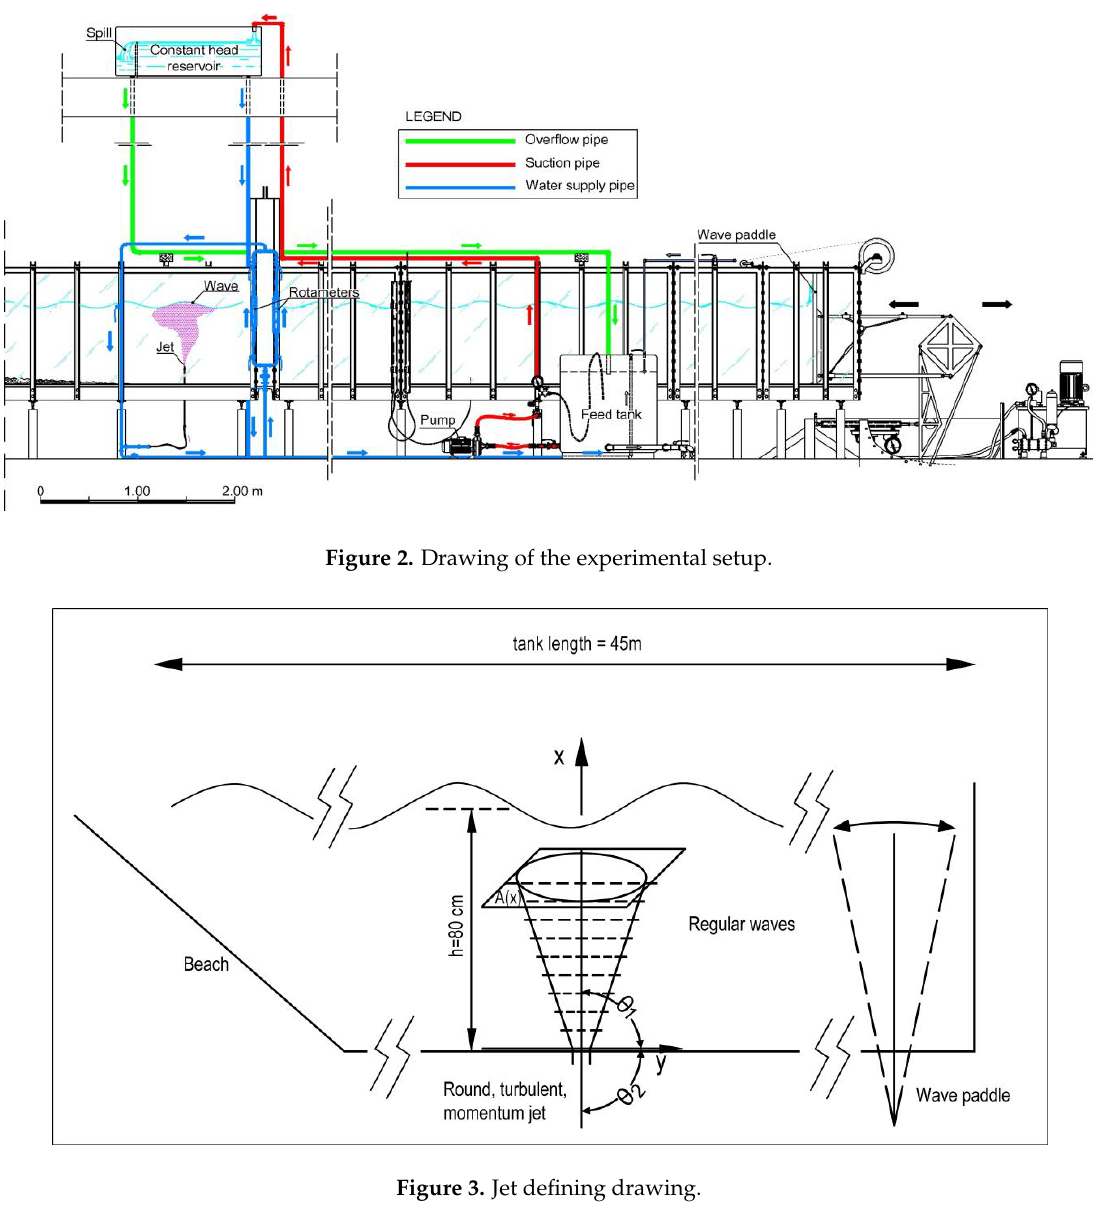
Figure 3. Jet defining drawing.